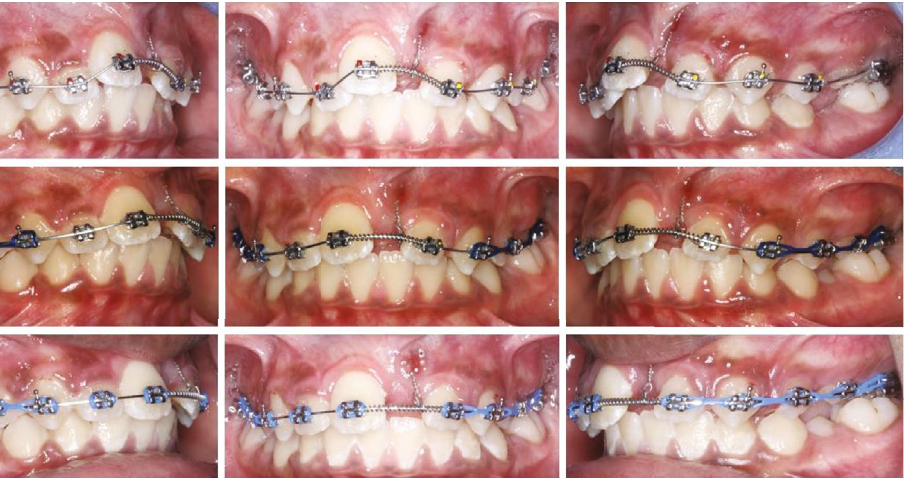
Figure 3: Initial stages.